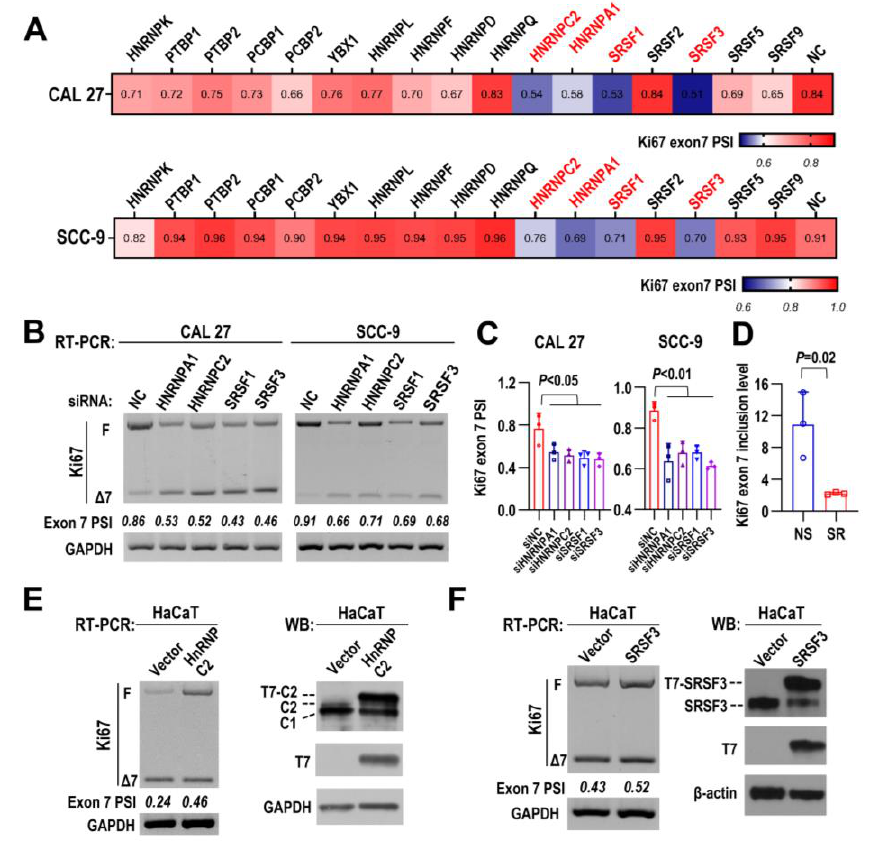
Figure 5. HNRNPC2 and SRSF3 are responsible for Ki67 exon 7 inclusion. ( A ) The specific siRNAs of multiple splicing factors and nonspecific control siRNA (NC) were transfected into CAL 27 and SCC-9 cells. The heatmaps displayed Ki67 exon 7 PSI values of CAL 27 and SCC-9 cells after siRNAs treatment. ( B , C ) RT-PCR results of alternative splicing of Ki67 exon 7 in CAL 27 and SCC-9 cells with HNRNPA1, HNRNPC2, SRSF1, and SRSF3 knockdown. PSI is calculated as F/(F + ∆ 7). The histograms show the statistical analysis. Data are mean ± SD, n = 3. ( D ) Comparison of the Ki67 exon 7 inclusion levels in SRSF3 knockdown (SR) or control (NS) groups from GSE22149 dataset which used a SpliceArray to detect the targets of SRSF3. ( E , F ) HaCaT cells were stably transfected with hnRNPC2 ( E ) or SRSF3 ( F ) expression lentivirus. Alternative splicing of Ki67 exon 7 was detected by RT-PCR and GAPDH served as the loading control. Western blot displayed the overexpression efficiency of HNRNPC2 and SRSF3, GAPDH and β -actin served as loading controls.